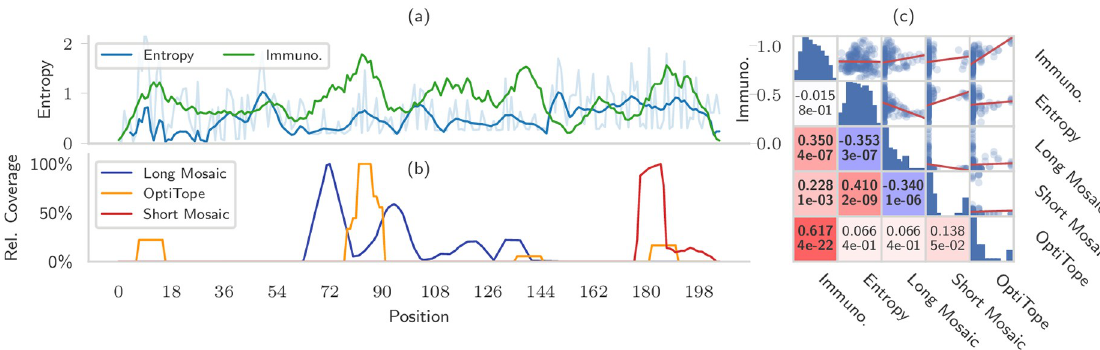
Fig 7. Mosaic vaccines naturally target conserved regions even when this is not required. (a) shows, for each residue position in aligned sequences where the consensus is not a gap, the smoothed entropy (blue, and residue entropy in lighter color) and the potential immunogenicity (green) (b) shows the number of pathogens covered in each position by a 20-epitopes mixture with maximal immunogenicity (yellow), a short mosaic of 28 amino acids (red) and a long mosaic of 90 amino acids (blue). The count is normalized separately for each vaccine to account for their different coverage. (c) shows the pairwise correlations of the variables shown in the left plot, so that every dot in the scatter plots corresponds to a different residue position, and linear fits are shown in red. The lower triangular half shows the Spearman correlation coefficients (above) and the respective p -value (below). Colors range from blue (large negative correlation) to white (no correlation) to red (large positive correlation), and the font is bold if the correlation is significant with a confidence of at least 99.5% at the Bonferroni-corrected significance level of 5%. The diagonal contains histograms showing the distribution of each variable, with logarithmic y